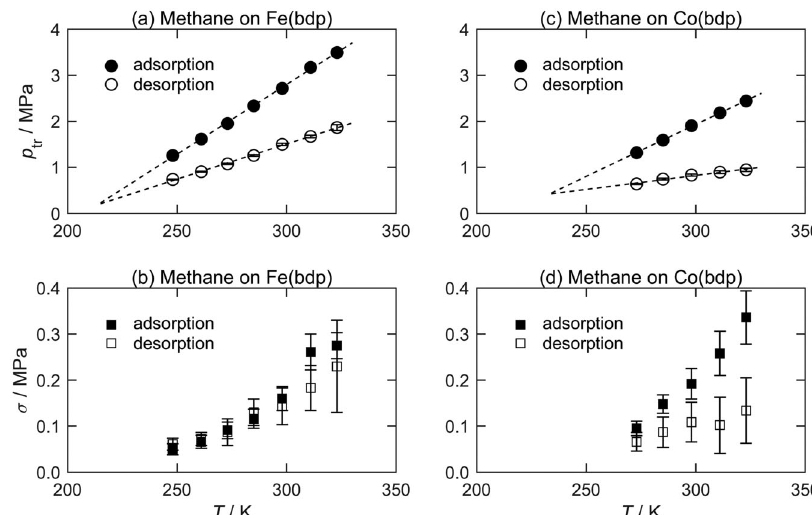
Fig. 2 Transition pressure and transition width vs temperature for the sorption of CH 4 on MOFs measured by Mason et al. 2 . Circles denote transition pressures, p tr , for a Fe(bdp) and c Co(bdp), while squares denote transition widths, σ , for b Fe(bdp) and d Co(bdp). Full symbols denote parameters from the adsorption branch and hollow symbols denote parameters from the desorption branch. Statistical uncertainties are shown as error bars in all panels, but are smaller than the symbol for p tr in a and c